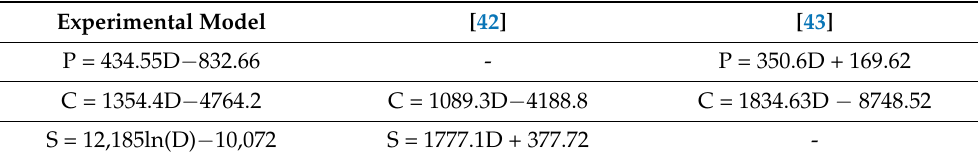
Table 3. Equations that link the diameter D to the power supplied to the excavation head (P), to the torque (C) and to the thrust (S) for the open TBMs.